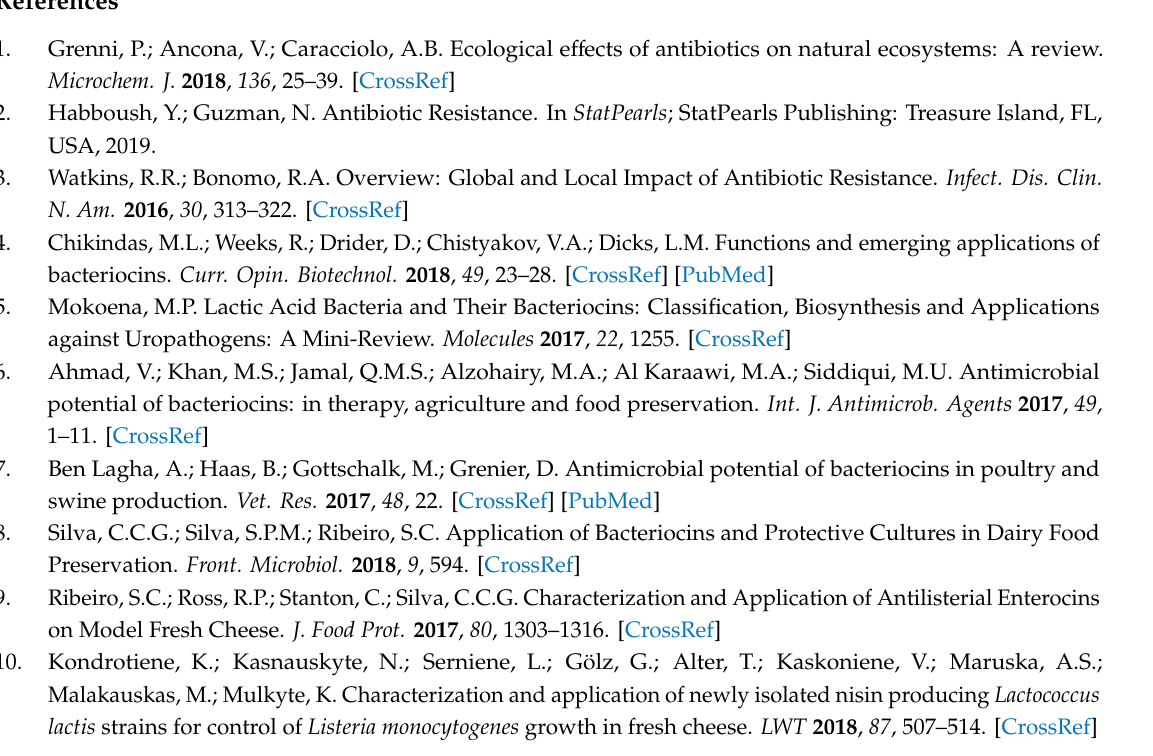
Supplementary Materials: The following are available online, Figure S1: Peptides mass fingerprint identified peocin as DNA starvation / stationary phase protection protein by LC / MS / MS